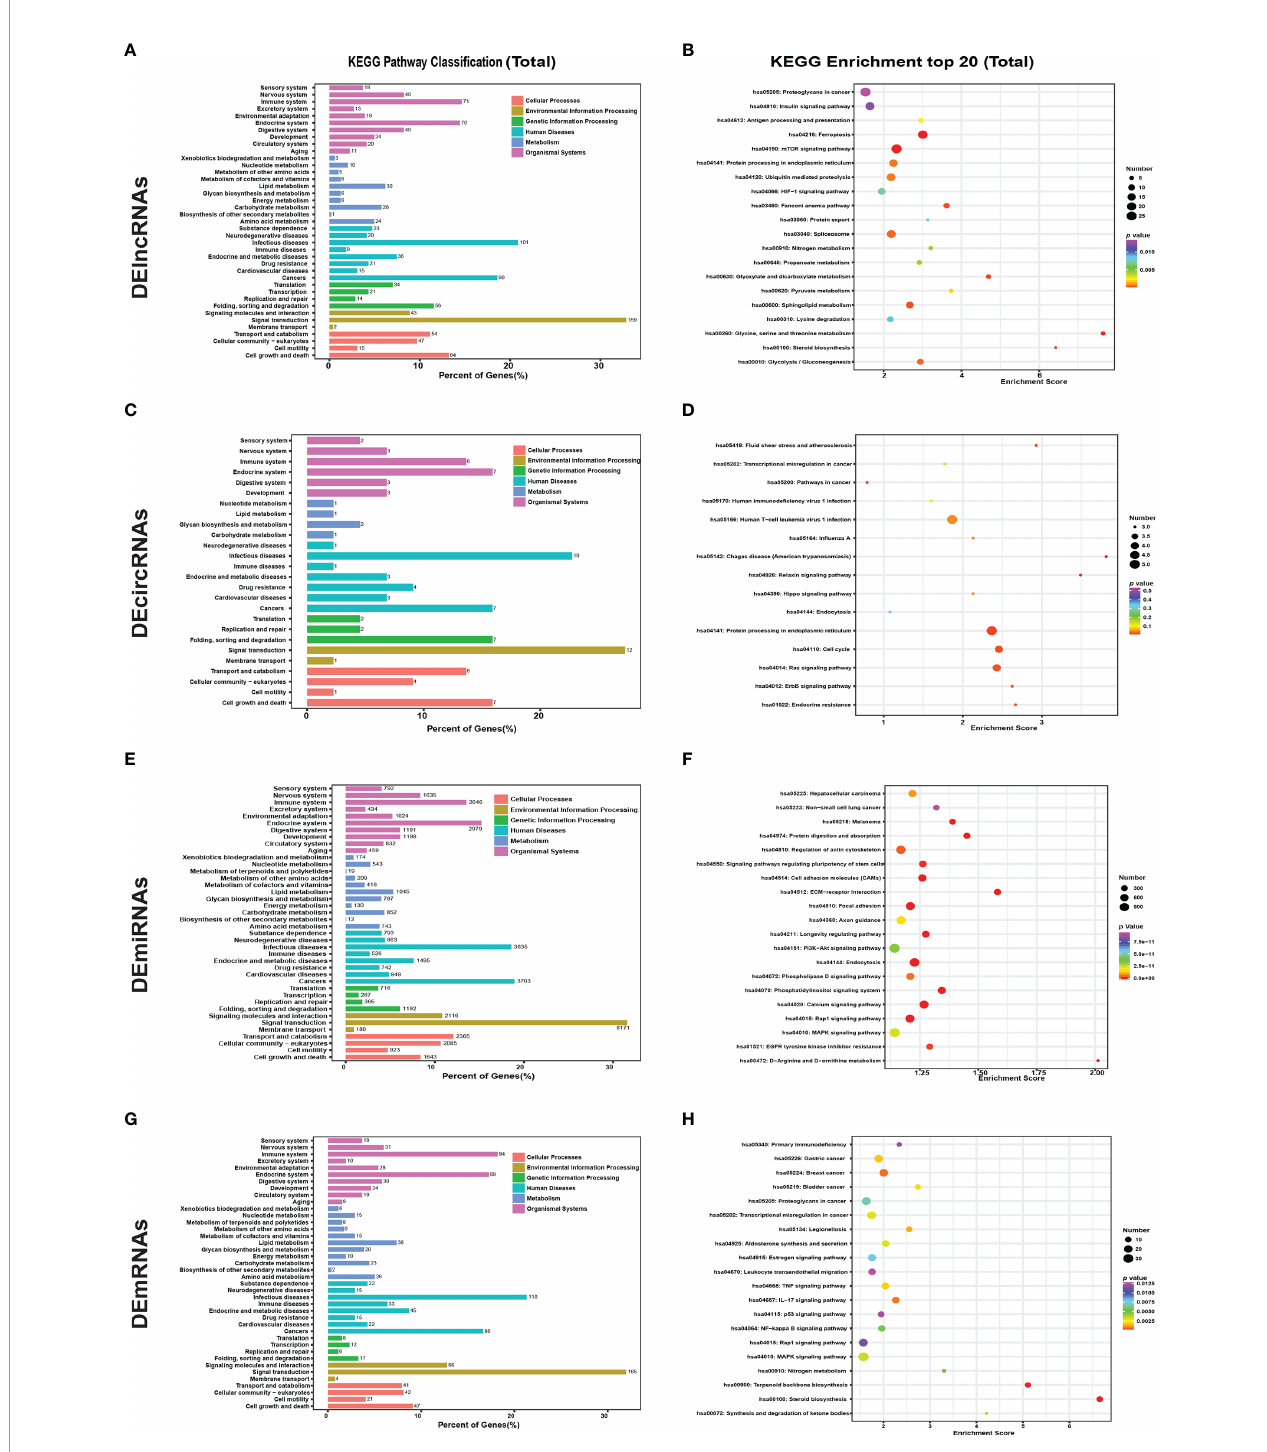
FIGURE 4 | KEGG pathway analysis of DEGs in different groups and scatter plot of the top 20 enriched KEGG pathways. KEGG pathway enrichment analysis of all (A) DElncRNAs, (C) DEcircRNAs, (E) DEmiRNAs, and DEmRNAs (G) between untreated and GA-Me-treated HCT116 cells. Scatter plot of the top 20 enriched KEGG pathways. Top 20 KEGG pathways identi fi ed for all (B) DElncRNAs, (D) DEcircRNAs, (F) DEmiRNAs, and DEmRNAs (H) between untreated and GA-Me- treated HCT116